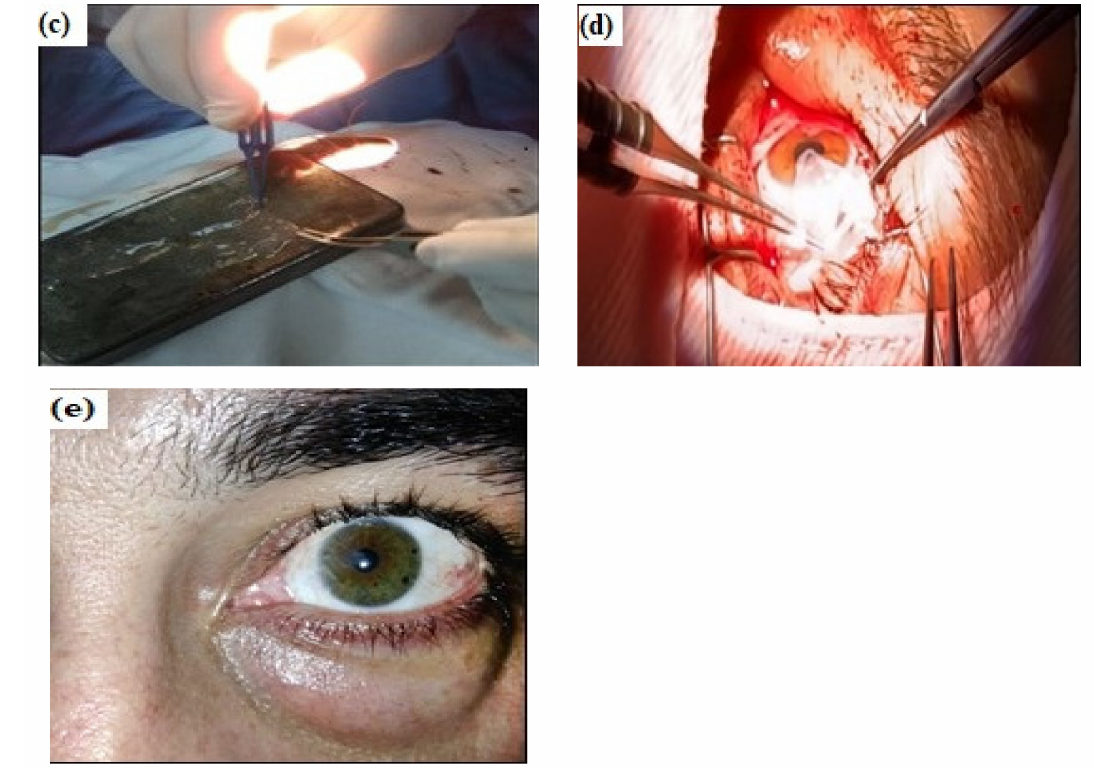
Figure 9. Amniotic membrane used in ophthalmologic surgery to cover the remaining tissue defect due to the grade 3 recurrent pterygium excision: ( a ) grade 3 recurrent pterygium, preoperative appearance; ( b ) intraoperative aspects (the same patient); ( c ) intraoperative preparation of the amniotic membrane fragment to be applied on the remaining defect following recurrent pterygium excision; ( d ) intraoperative appearance—application of the AM fragment on the remaining defect and 10.0 thread suturing to the bulbar conjunctiva of the fragment; ( e ) the aspect of the patient’s cornea four weeks after surgery (from private collection of Claudia Florida